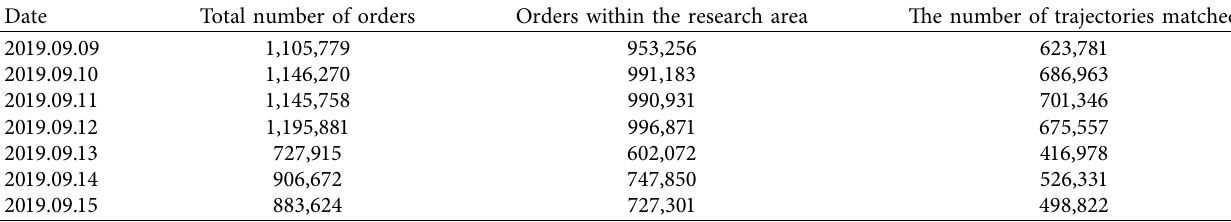
Table 3: Data processing results.